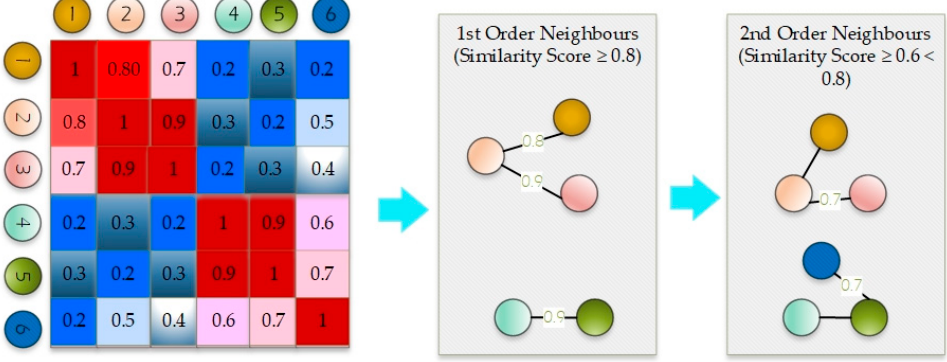
Figure 5. Threshold-based neighbor sampling of nodes.